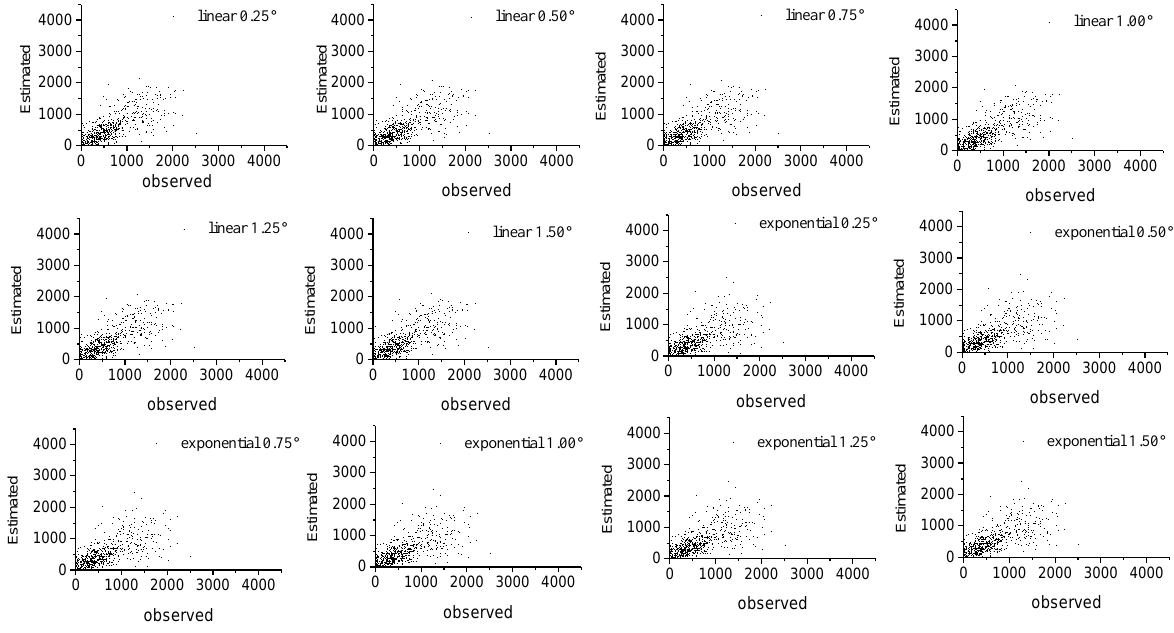
Figure A3. The final predicted annual precipitation of China mainland at the 1 km resolution for the year 2001 using the multiple linear regression models ( A ); exponential models ( B ); and random forest models ( C ) built at spatial resolutions of ( a ) 0.25°, ( b ) 0.50°, ( c ) 0.75°, ( d ) 1.0°, ( e ) 1.25°, and ( f ) 1.50°, respectively.